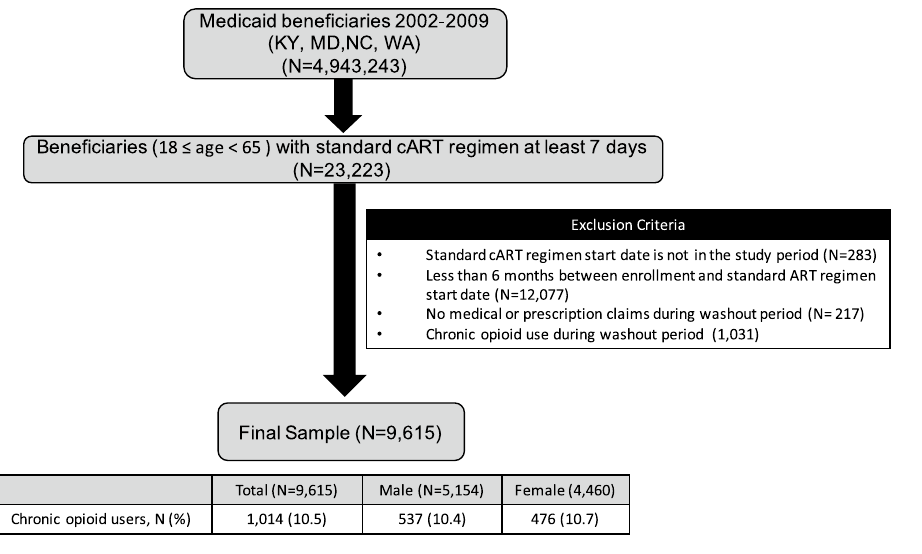
Figure 1. Sample selection